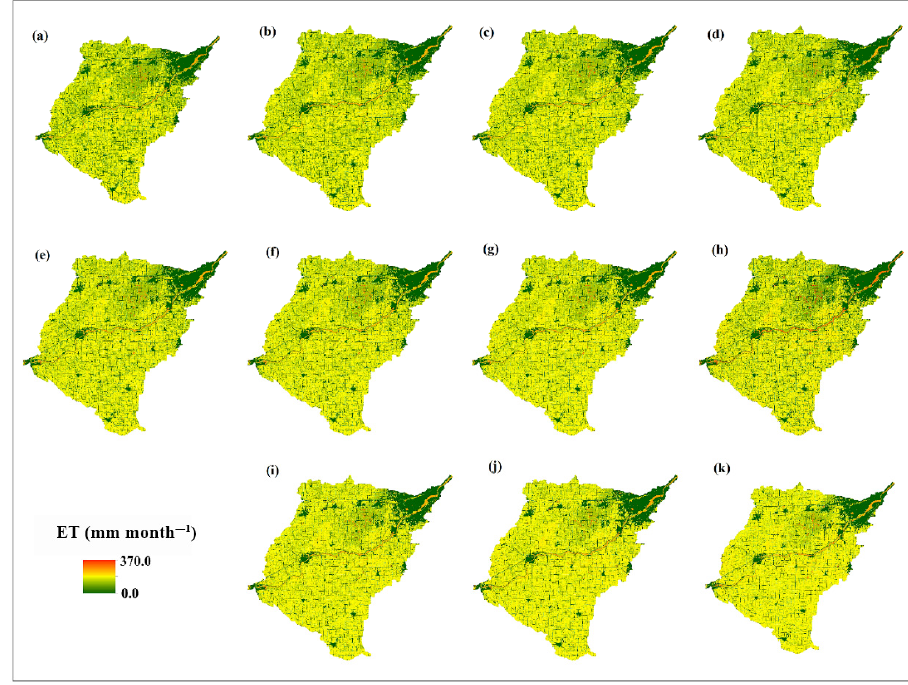
Figure 11. BEPS-generated ET images under different percentages of corn cover in July. ( a ) ET image generated using reclassified USDA LULC image (USDA, 2018); ( b – k ) ET images for sequential 10% incremental increases in corn cover.